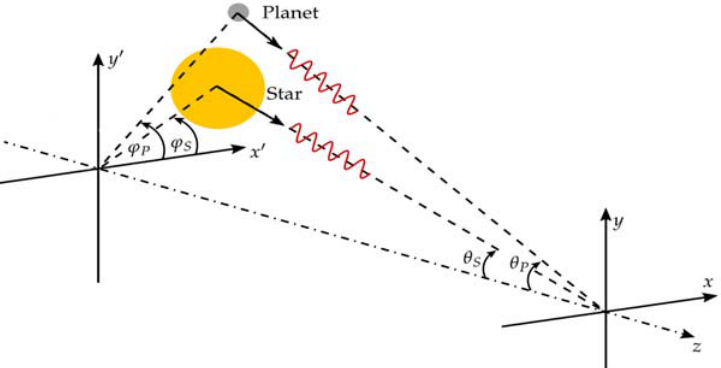
Figure 1. Star ‐ planet system in x ′ ‐ , y ′ ‐ coordinate system, viewed from the rotational shearing interferometer at the origin of coordinate system (x,y,z) on or near the Earth. The star and the planet may be modeled as point sources with an elevation ‐ angle, θ (measured from the negative optical axis), and an azimuth ‐ angle, φ , with respect to the x´ ‐ axis. The planet quantities have a subscript P , those of the star have S . The star coordinates correspond to the alignment error. The planet coordinates are unknown because it is